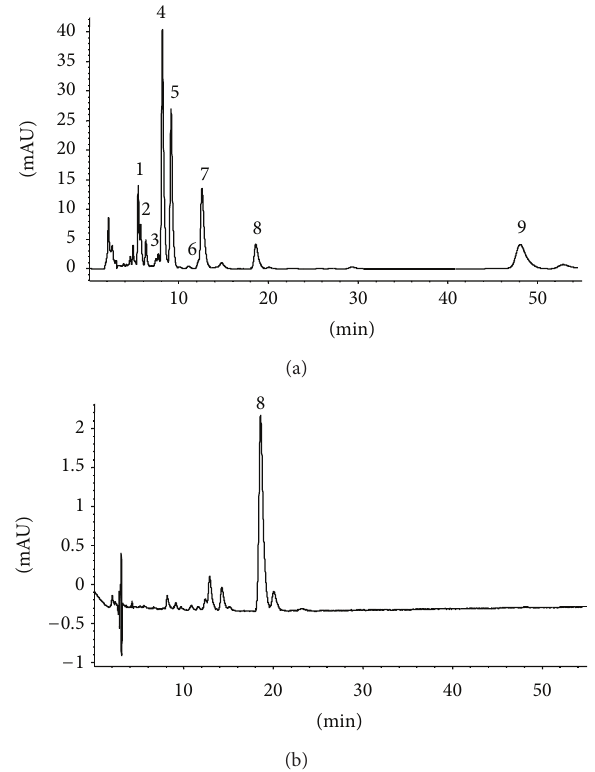
Figure 1: HPLC chromatogram of Allium fistulosum L. leaf (a) and pseudostem (b) tissues at 453 nm. Retention times (min) for the pigments were (1) violaxanthin, 5.52 min; (2) neoxanthin, 5.81 min; (3) antheraxanthin, 7.59min; (4) chlorophyll b , 8.51min; (5) lutein, 9.33 min; (6) zeaxanthin, 11.31min; (7) chlorophyll a , 13.90 min; (8) ethyl- 𝛽 - 8 󸀠 -apo-carotenoate (internal standard), 19.32 min; and (9) 𝛽 -carotene, 48.46 min. HPLC conditions are described in the